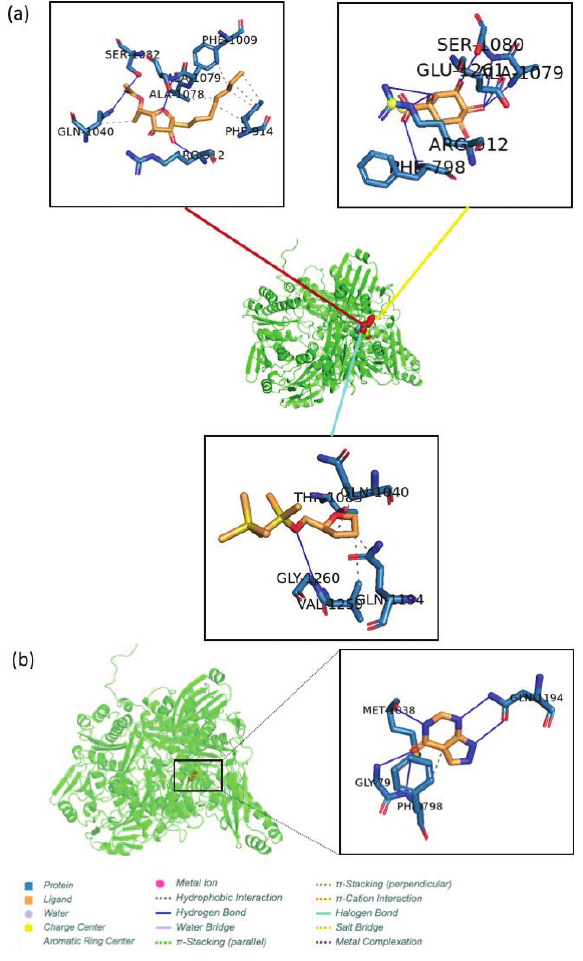
Figure 7. Binding poses of ligand in complex with a receptor (XO). Complex 1 consisted of mixed compounds where the red, yellow, and cyan lines refer to 5-O-acetyl-thio-octyl-β-L-rham- nofuranoside, quinic acid, and 2-dimethyl(trimethylsilylmethyl) silyloxymethyltetrahydrofuran compounds, respectively, (b) com- plex 2 denoted to allopurinol (control). The PLIP program (Salen- tin et al. 2015) and Pymol v 2.3 program packages (DeLano. 2002) was used to display the conformational poses of each complex. Table 5. The hydrogen bonds of ligand in complex with the receptor. Complex